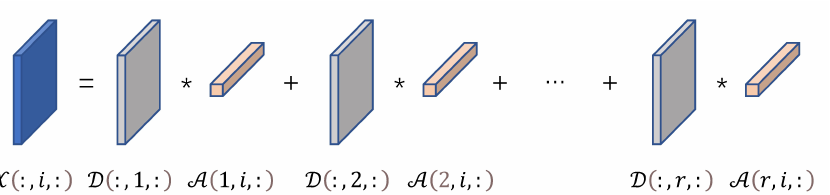
Figure 1. A tensor signal represented by a tensor-linear combination of i tensor dictionary atoms.